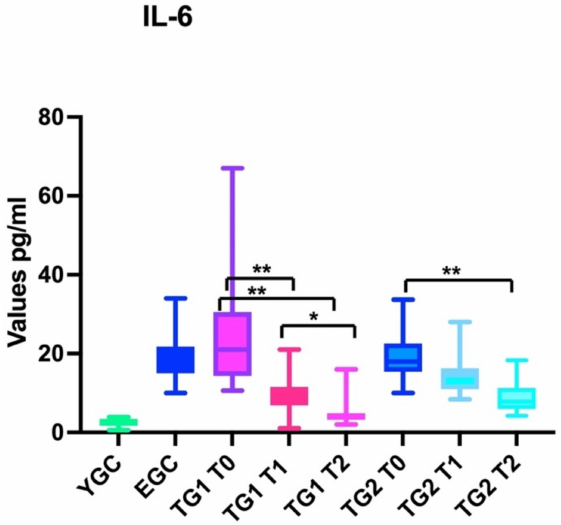
Figure 3. The box graph shows the differences in the IL-6 levels between young control group (YCG), elderly control group (ECG), treatment group 1 (TG1), and treatment group 2 (TG2); for TG1 and TG2, T1 and T2 were described also. YCG and ECG were always statistically significant different from TG1 and TG2 at T1 and T2. ** p < 0.01 * p < 0.05.